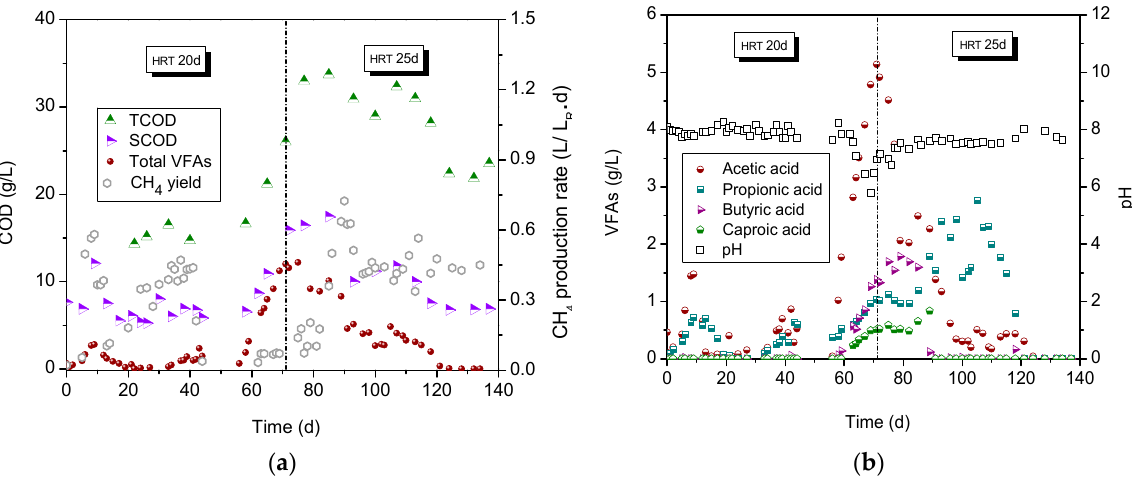
Figure 6. Evolution of ( a ) total concentration of soluble COD and total VFA (in COD units) and methane production rate; ( b ) concentration of main VFAs and pH during methanogenesis for each HRT tested.